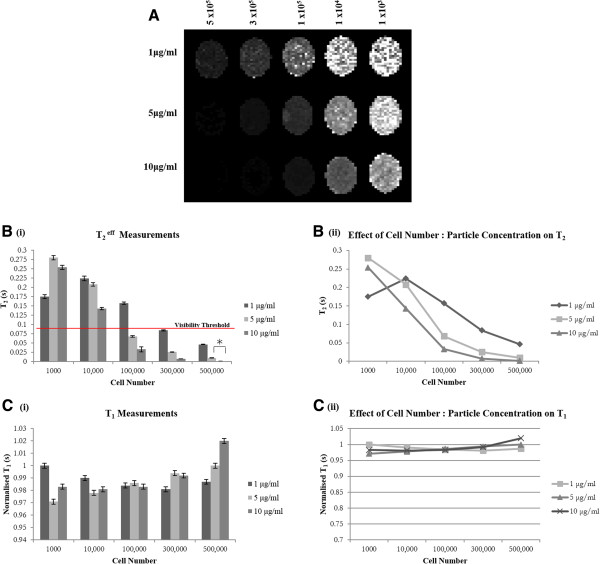
In vitro dose response. A) T2eff map for 1, 5 and 10 μg/ml SiMAG-labelled cells ranging in cell doses (103, 104, 105, 3 × 105, 5 × 105). B) Bar chart depicting i) T2 and ii) normalised T1 measurements at each particle concentration (1 to 10 μg/ml) and cell dose (103, 104, 105, 3 × 105, 5×105). Red line indicates MRI visibility threshold implying that any cell: particle combination resulting in a T2 less than 0.084 ms can be detected by MRI. C) Plot to show correlation between number of cells and i) T2eff and ii) normalised T1 for three different concentrations (1, 5 and 10 μg/ml) of SiMAG. Data = average ± SD (n = 6). Assume *** significant levels unless otherwise stated (P <0.005). *Indicates significant statistical difference in T2 between 500,000 cells labelled with either 5 μg/ml or 10 μg/ml (P <0.01). MRI, magnetic resonance imaging; T1, longitudinal relaxation time; T2, transverse relaxation time; T2eff, effective transverse relaxation time.